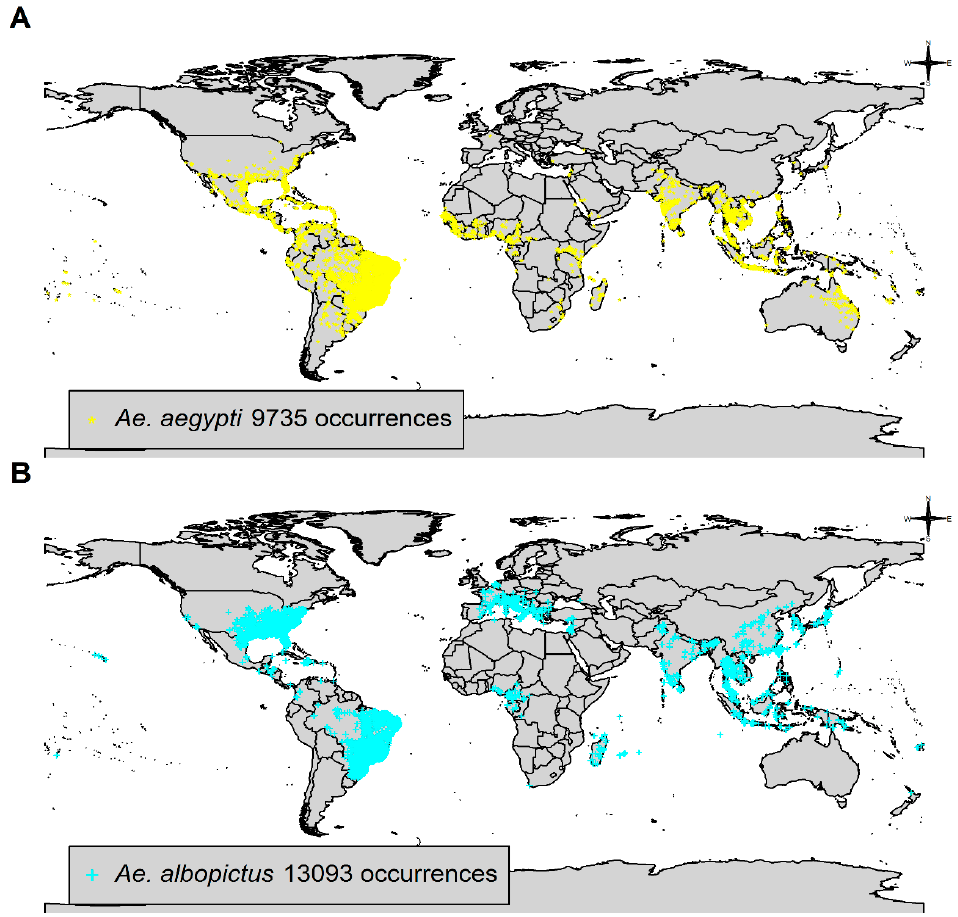
Figure 1. VectorMap species occurrence data: ( A ) Aedes aegypti; and ( B ) Aedes albopictus as adults (females, males) or immatures (larvae). Georeferencing of point coordinates was effectuated in decimal degrees of latitude and longitude in WGS84. World country map was based on simplified world country polygons by the National Aeronautics and Space Administration (NASA).